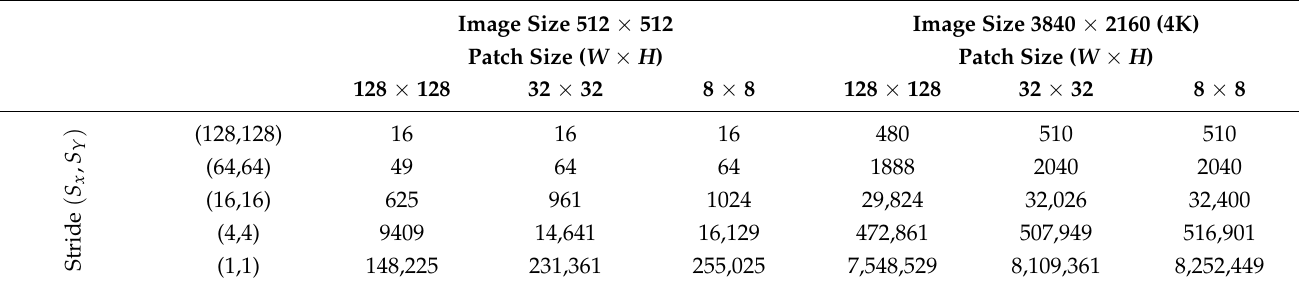
Table 1. Overall number of patches for various stride and patch sizes in a medium-sized image (512 × 512 pixels) and a 4K image (3840 × 2160 pixels).